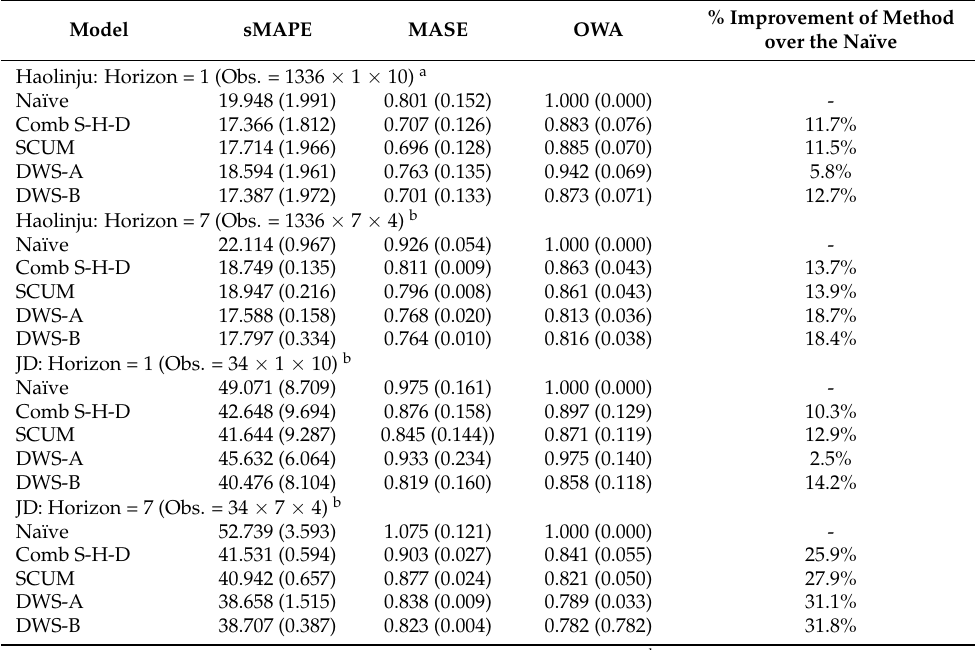
Table 3. The performance of the five methods for rolling forecast testing in the smooth pattern. Model sMAPE MASE OWA